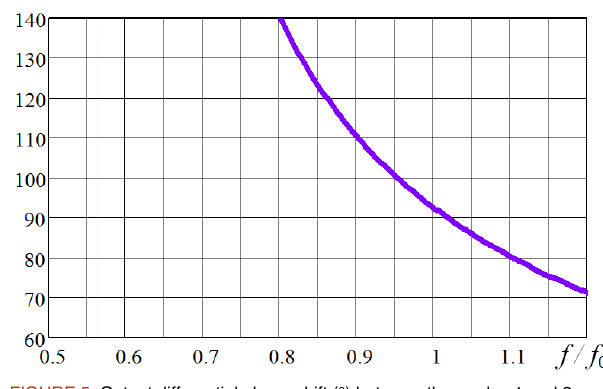
FIGURE 5. Output differential phase shift (°) between the modes 1 and